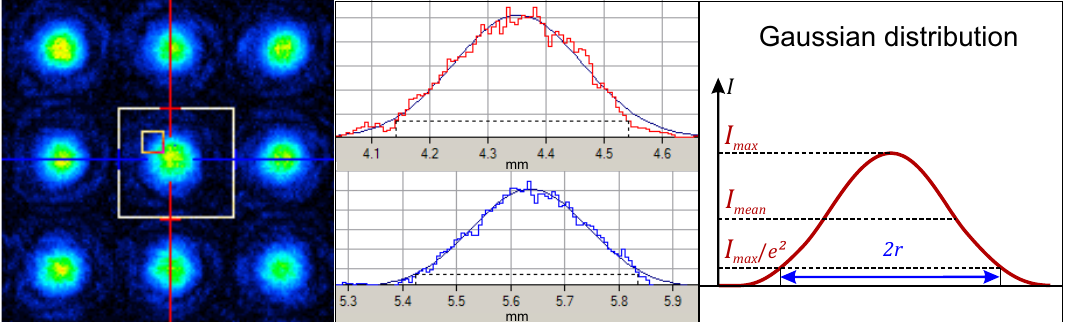
Figure 4. Gaussian intensity distribution of laser beams in the grid at a working distance of 65 mm: cross-sectional measurement of individual laser spots and determination of 1/e 2 radius at 400 µ